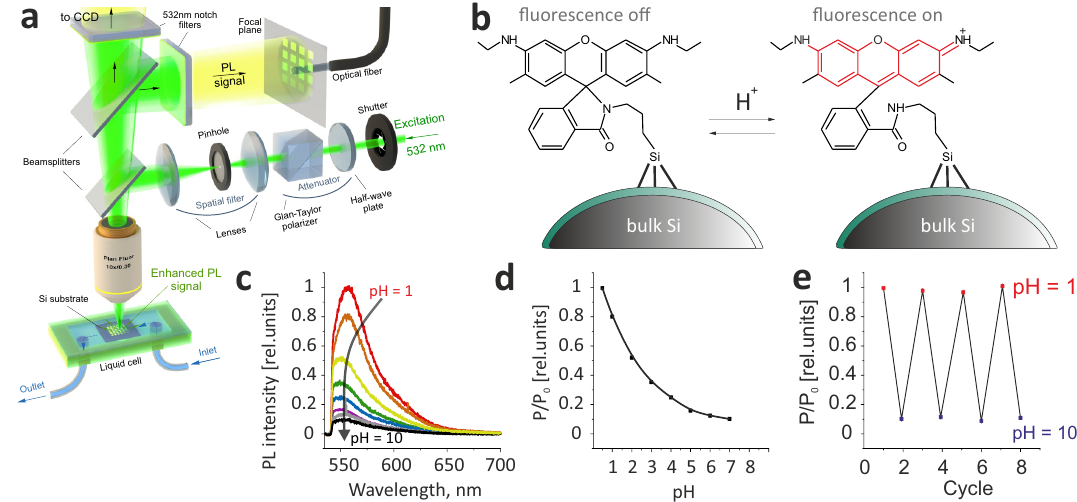
Figure 3. ( a ) Experimental setup for PL measurements and pH sensing tests. ( b ) Spirolactam ring-opening reaction. ( c ) A series of PL spectra of the pH sensitive laser-textured surface upon successive acidification of the surrounding solution. ( d ) Dependence of the normalized PL intensity P/P 0 on pH value. ( e ) Change in signal intensity upon cyclic filling of the microfluidic cell with basic (pH = 10) and acidic (pH = 1)